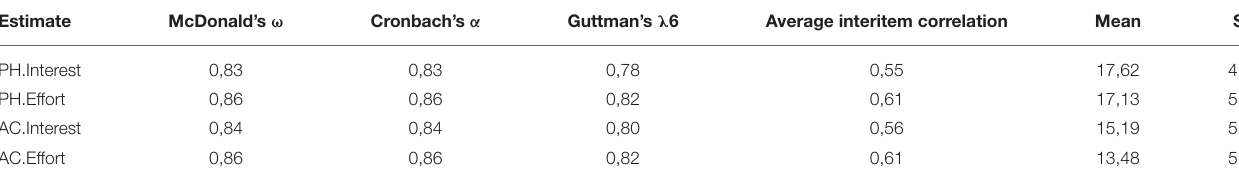
TABLE 3 | Internal consistency of PE-Grit